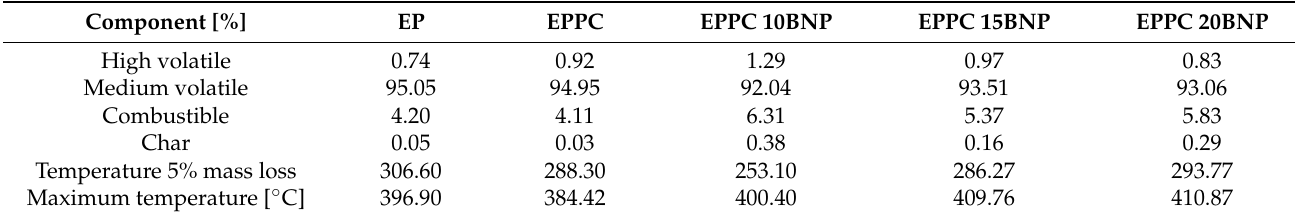
Table 1. Compositional analysis by ASTM E1131, onset of degradation temperature and maximum degradation temperature.